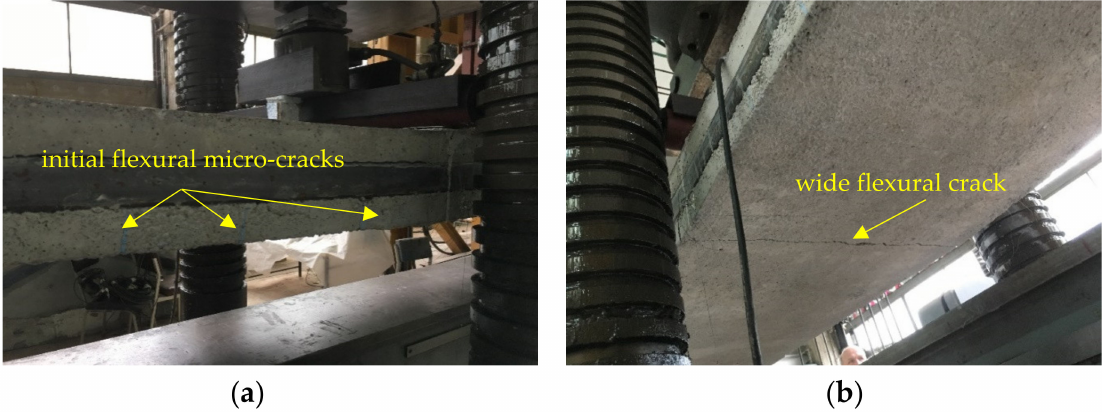
Figure 5. Failure mechanism of PCSP-1 specimen under three-point bending: ( a ) flexural micro-cracks on the tensile concrete panel and ( b ) wide flexural crack on the tensile concrete